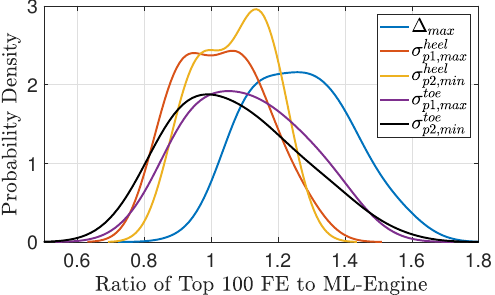
Figure 13. Kernel distribution fitted on the ratio of FE to ML-engine